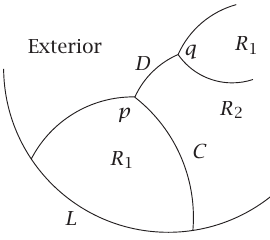
Figure 6.6 . The boundary between the exterior and R point q